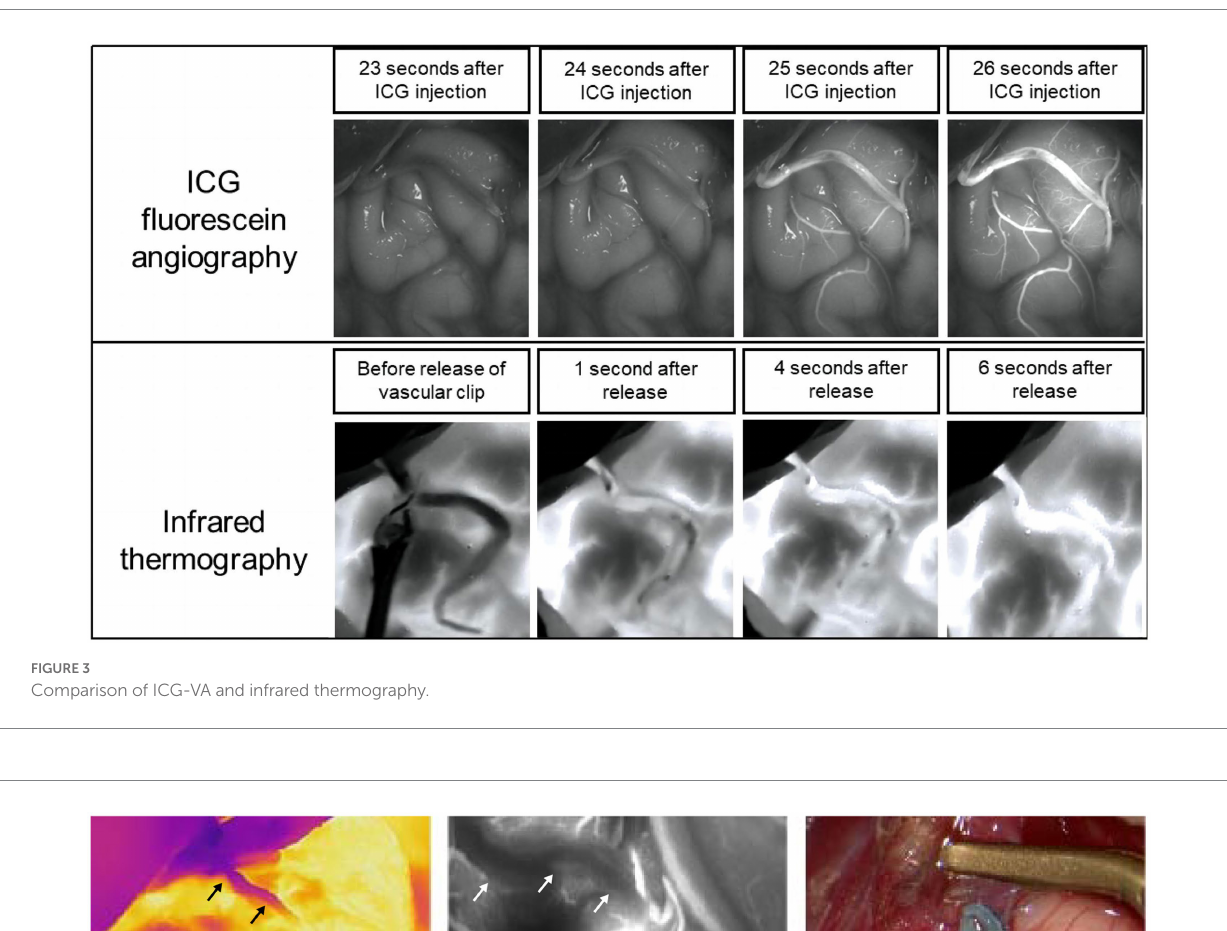
FIGURE 3 Comparison of ICG-VA and infrared thermography.